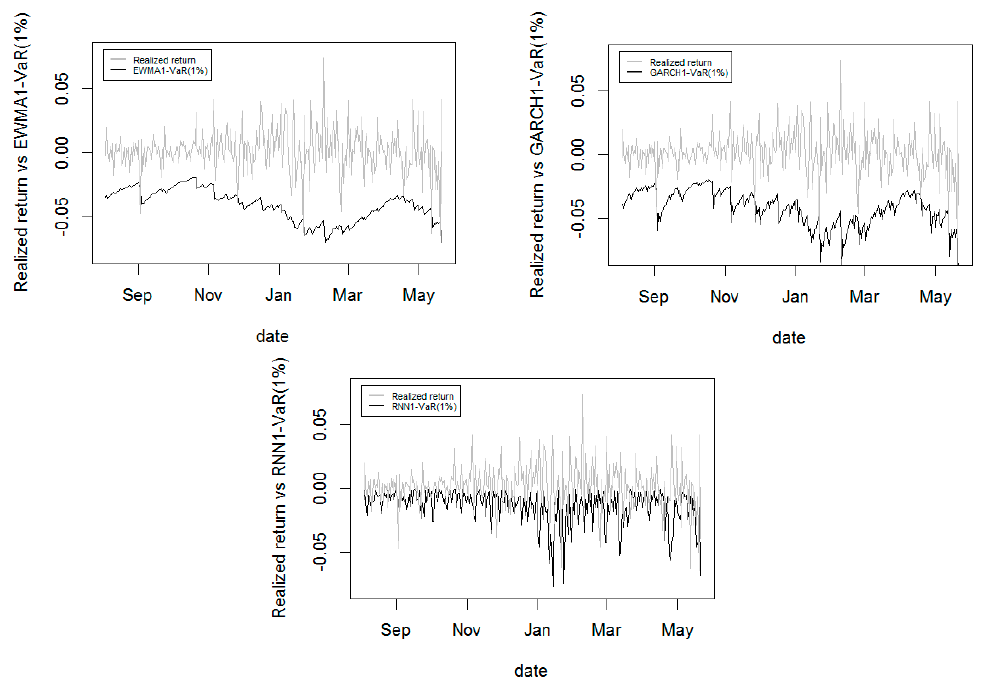
Figure 6. Out of sample realized return vs. one day ahead VaR (1%) of EWMA, GARCH, and RNN model. EWMA1, GARCH1, and RNN1 denote the one day ahead forecasting of each model.